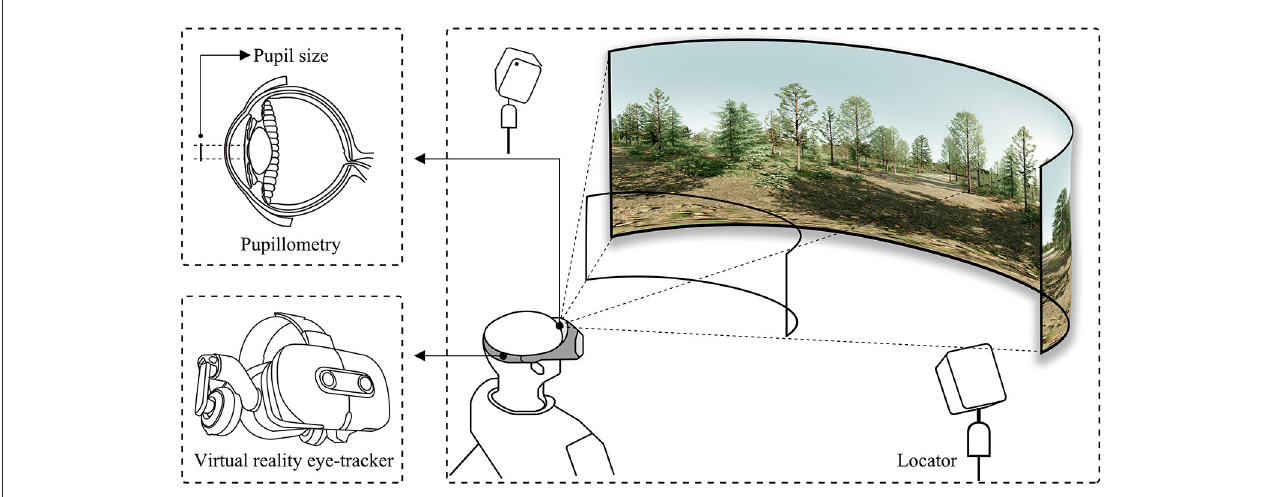
FIGURE6 View schematic of the virtual reality eye-tracking experiment.